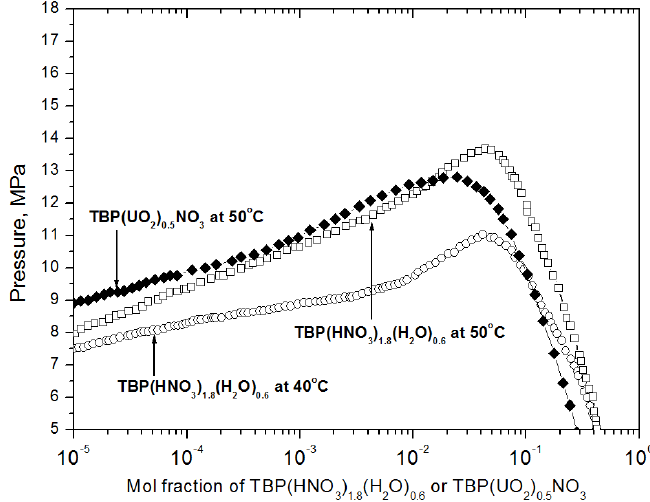
Figure 1. Solubility curves for the transition pressures from two-phase to single-phase TBP·(UO 2 ) 0.5 ·NO 3 and TBP·(HNO 3 ) 1.8 ·(H 2 O) 0.6 in supercritical CO 2